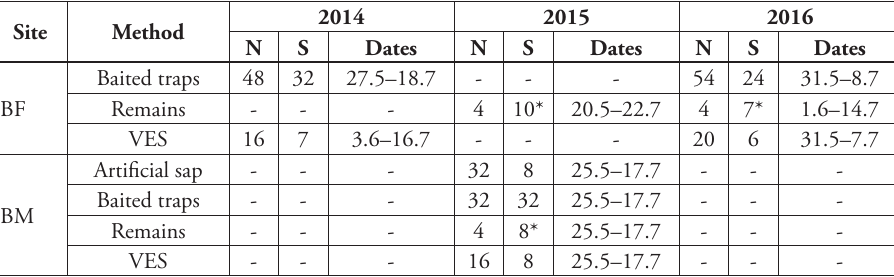
Table 1. Sampling plan at Bosco della Fontana (BF) and Bosco della Mesola (BM) during the three years of monitoring. N = number of transects or traps; S = number of surveys; * indicates the number of surveys for each